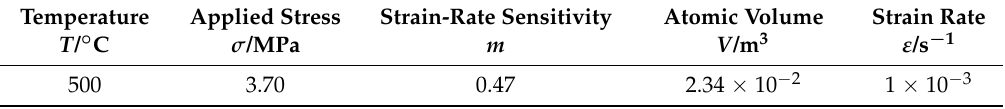
* The material constants used for 5A70 alloy: δ = 5.72 × 10 − 10 m, k = 1.38 × 10 − 23 J · K − 1 , D gb = 3.3 × 10 − 14 m 3 · s − 1